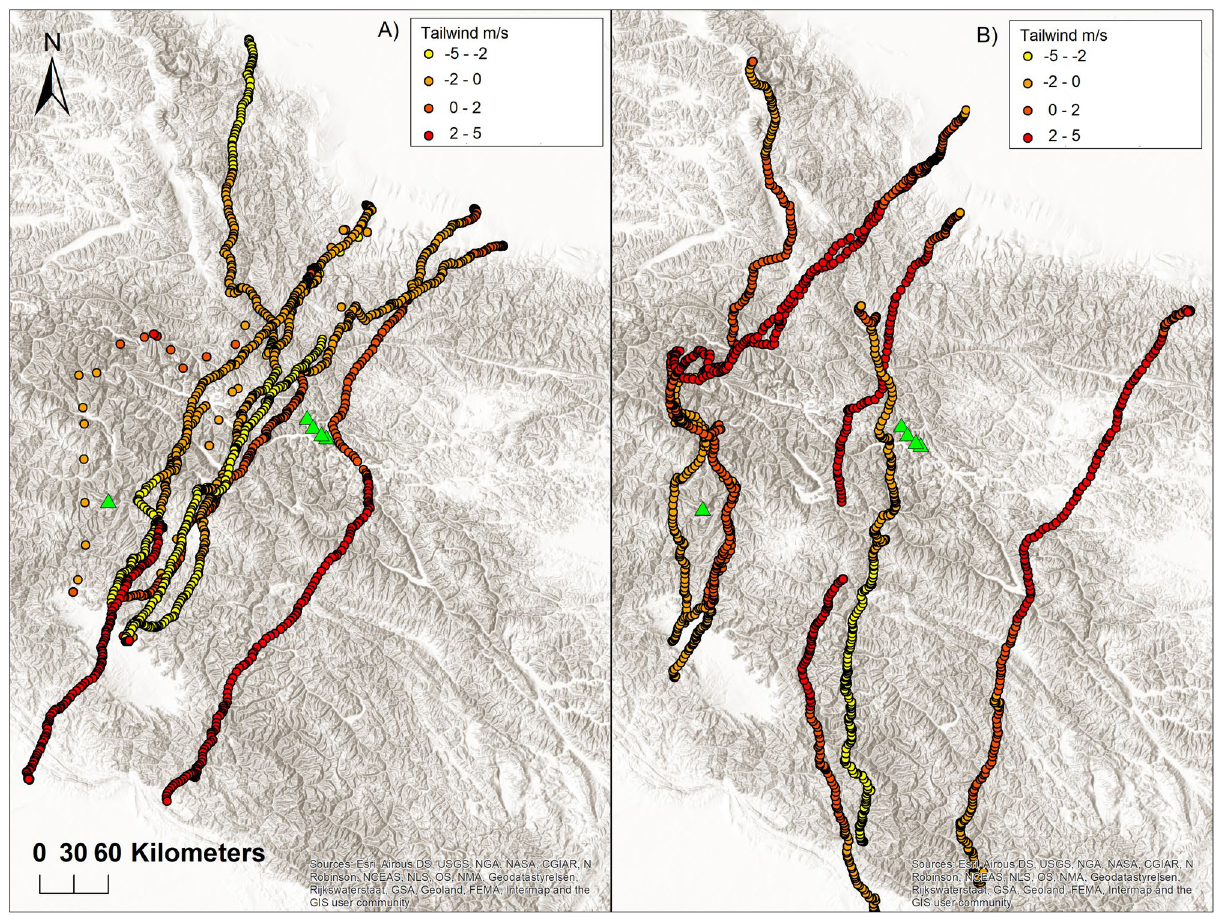
Figure 5. Post-breeding ( A ) and pre-breeding ( B ) crossing over the Himalayas in relation to tailwind speed. Green triangles represent mountain peaks over 8000 m. Figure was created using software ArcGIS 10.1 (Esri, Redlands, CA, USA). Map source: Esri, USGS, Airbus DS, NGA, NASA, CGIAR, N Robinson, NCEAS, NLS, OS, NMA, Geodatastyrelsen, Rijkswaterstaat, GSA, Geoland, FEMA, Intermap, and the GIS user community, "Wolrd Hillshade", October 18. 2018. https:// www. arcgis. com/ home/ item. html? id= babed c22eb d64a4 28b77 f7119 c2591 c3. Accessed on October 26. 2021. Dependant